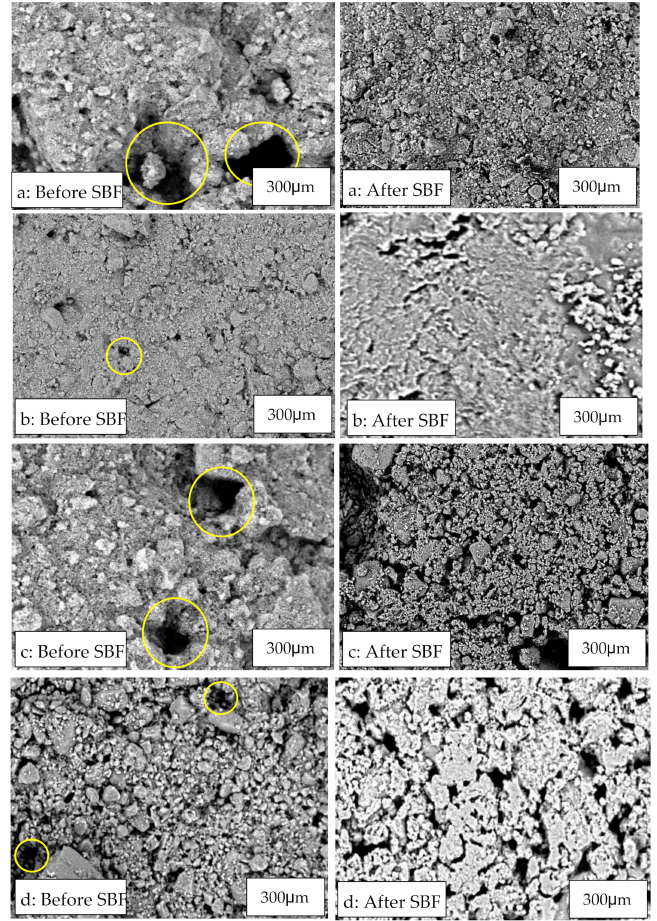
Figure 6. SEM micrographs of cross-sections of HAp/BG composite and HAp samples after hard- ening: ( a ) HAp50/BG50, ( b ) HAp70/BG30, ( c ) HAp90/BG10, and ( d ) HAp scaffolds. Yellow areas indicate holes in cross-sections of